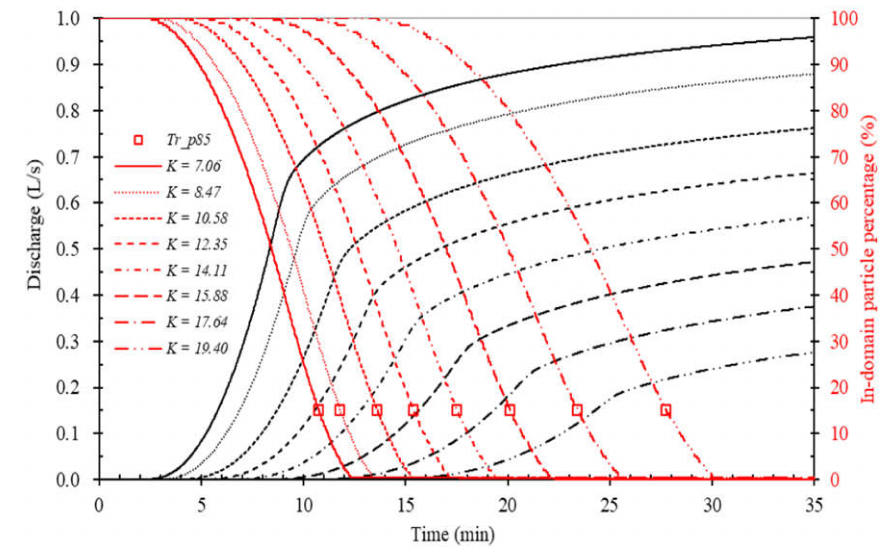
Figure 6. Simulated runoff hydrograph and in-domain particle percentage versus time for eight modeling cases of different saturation hydraulic conductivity ( K , in 10 − 6 m/s) with S 0 =0.01, i = 105.2 mm/h, L = 50 m, ϕ = 0.06 m, ∆ θ = 0.18 of pervious surfaces.